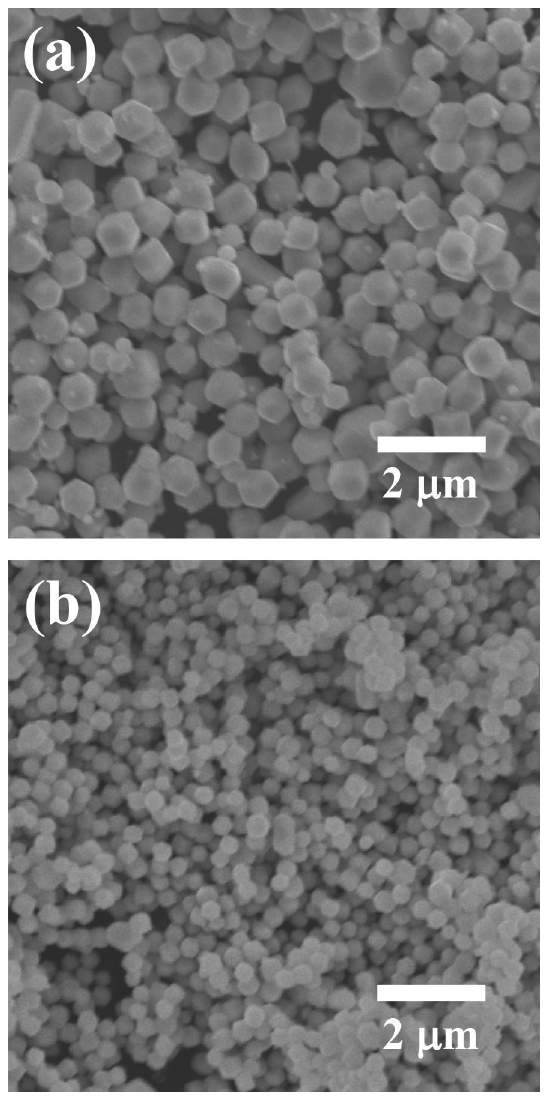
Figure 2. SEM images of microcrystals obtained for dropping rates of ( a ) 0.020 cm 3 s −1 and ( b ) 0.33 cm 3 s −1